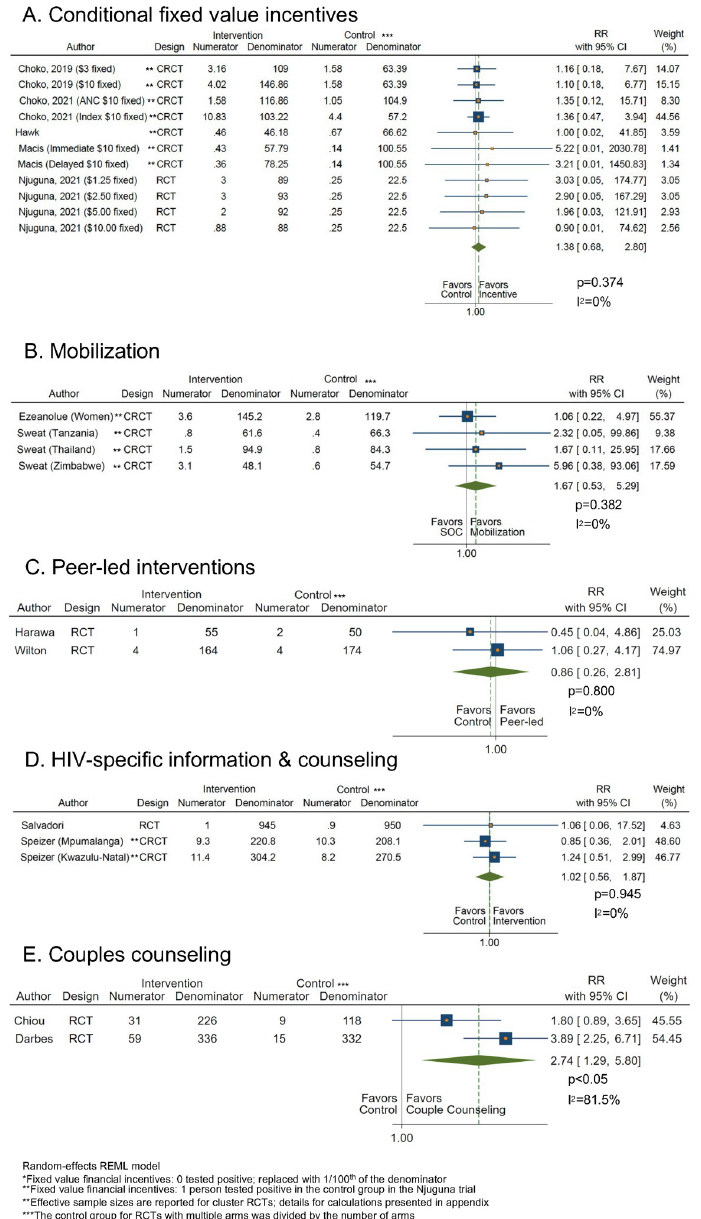
Fig 5. Meta-analysis plots of HTS yield in relative and absolute differences. Panels (A–E): (A) conditional fixed value incentives, (B) mobilization, (C) peer-led interventions, (D) HIV-specific information and counseling, (E) couples counseling. CI, confidence interval; CRCT, cluster-randomized trial; RCT, randomized controlled trial; RD, risk difference; REML, restricted maximum likelihood; RR, relative risk; SOC, standard of